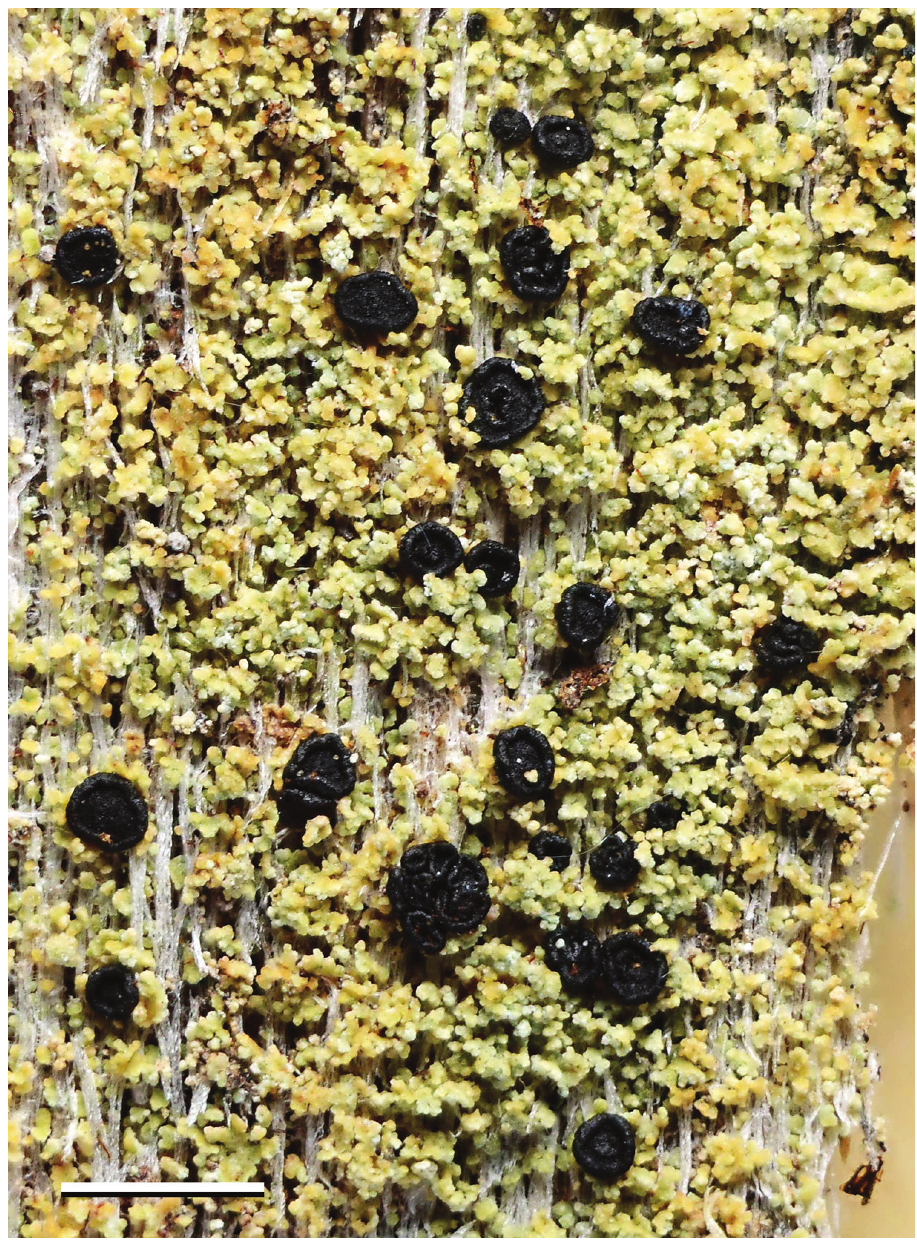
Figure 2. Xylopsora canopeorum, holotype. Scale bar: 1 mm. Description. Thallus crustose to squamulose; individual squamules up to 0.5 mm diam. but often soon breaking up into a coralloid crust, adnate when young, later ascend- ing and more or less geotropically imbricate; soralia occurring patchily, labriform,